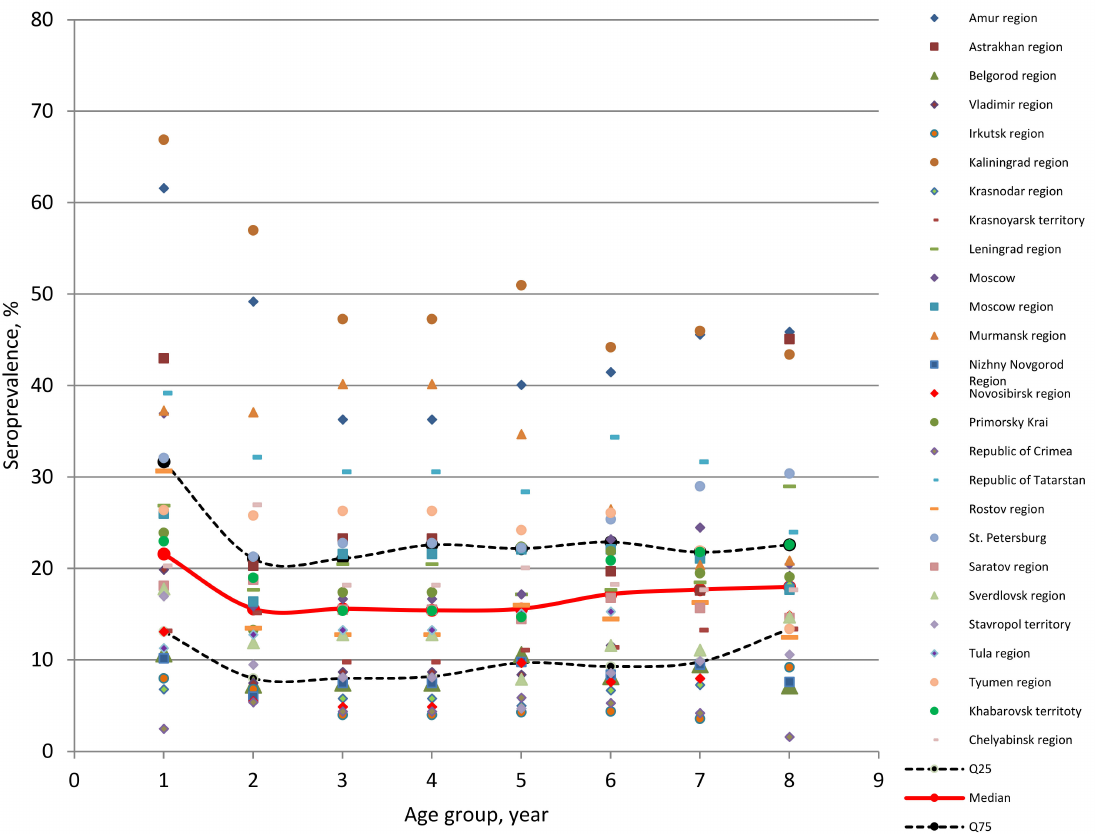
Figure 4. Distribution of volunteer seroprevalence by region and age. Solid curves correspond to: Me (median); Q25 (bottom); and Q75 (top). Dots indicate volunteer seropositivity values in 26 model regions (legend), distributed over 7 age